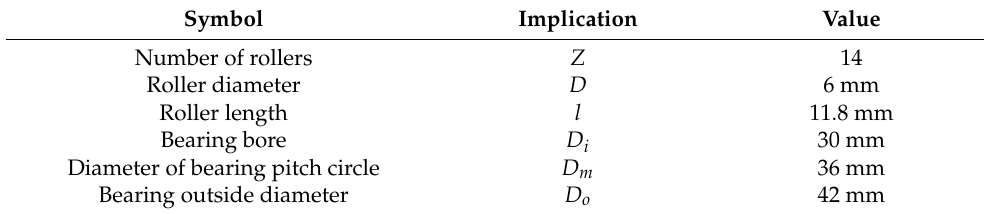
Table 1. Characteristic parameters of roller